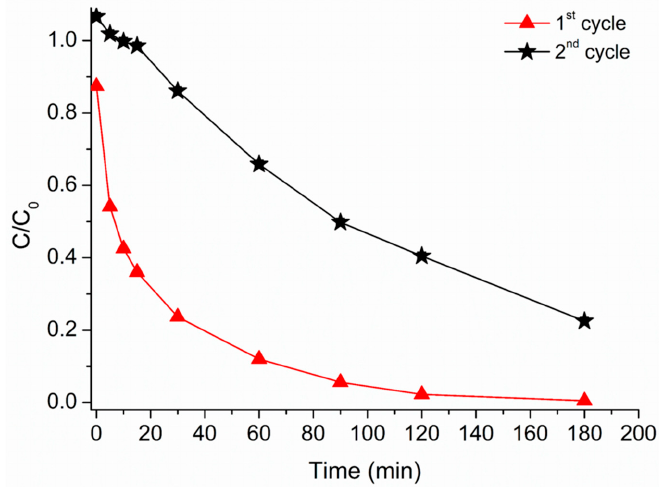
Figure 8. Caffeine relative concentration vs. irradiation time. 1st cycle (red triangles); 2nd cycle (black stars). MH0.2 200 mg·L − 1 , H 2 O 2 1.50 × 10 − 3 M. Data reported considering an initial caffeine concentration of 5 mg·L − 1 .